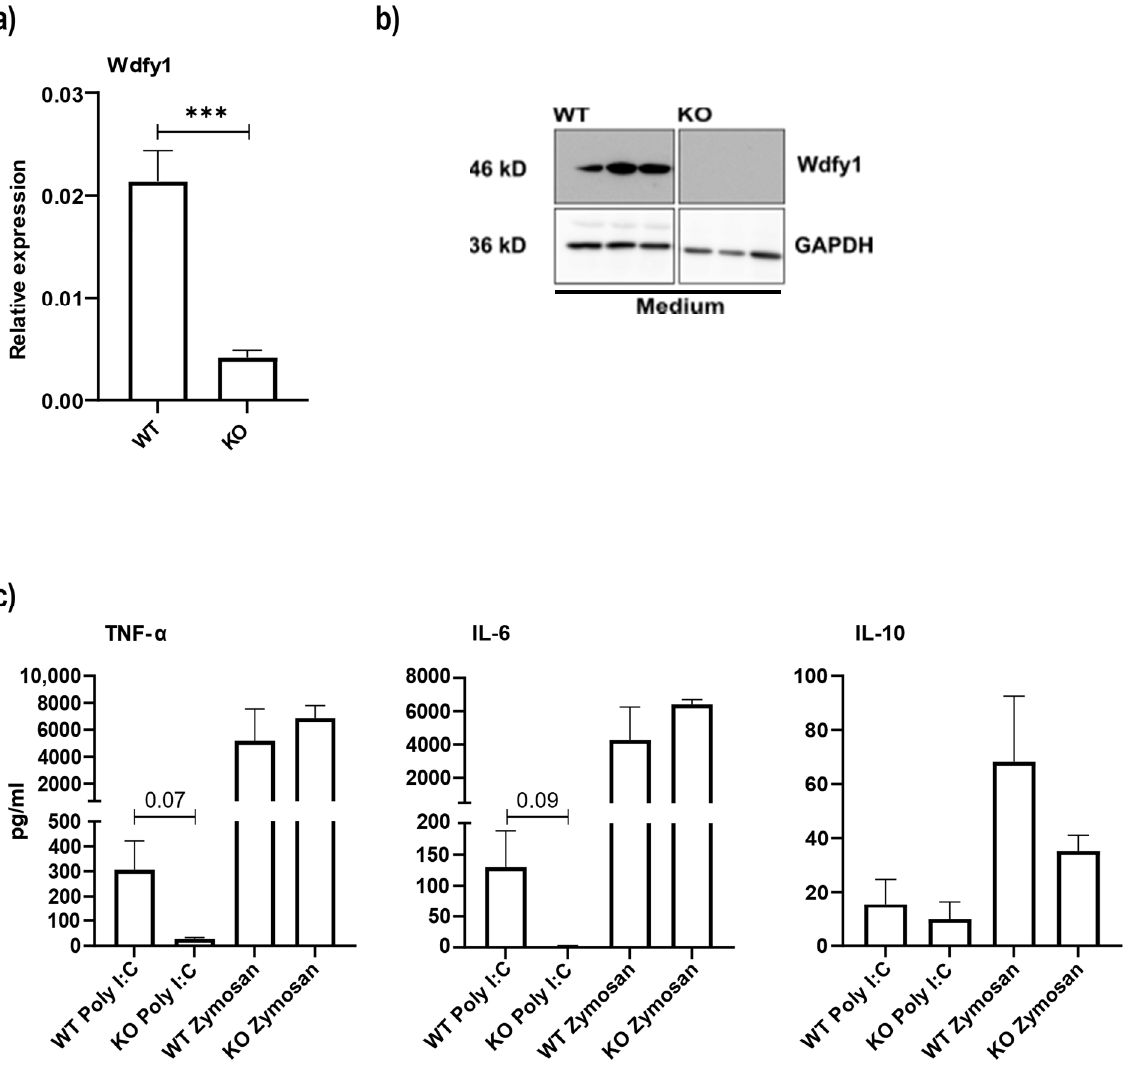
Figure 5. Role of Wdfy1 in affecting antimicrobial responses. ( a ) Wdfy1 gene expression in bone marrow-derived M2 macrophages by qPCR. mRNA levels were normalized for their reference genes. N = 5 WT and 5 miR-511-deficient mice. ( b ) Wdfy1 protein expression in M2 differentiated BMDMs in triplicates per group as seen by western blot. N = 3 WT and 3 miR-511 deficient ( c ) Cytokine response (TNF- α , IL-6 and IL-10) by BMDM after Poly I:C and Zymosan stimulation by CBA. N = 3 for both groups. Individual values are expressed as mean and standard error of the mean. Statistical differences were tested by independent t -test, where a p -value of <0.05 was considered to be significant. *** p -value < 0.001.